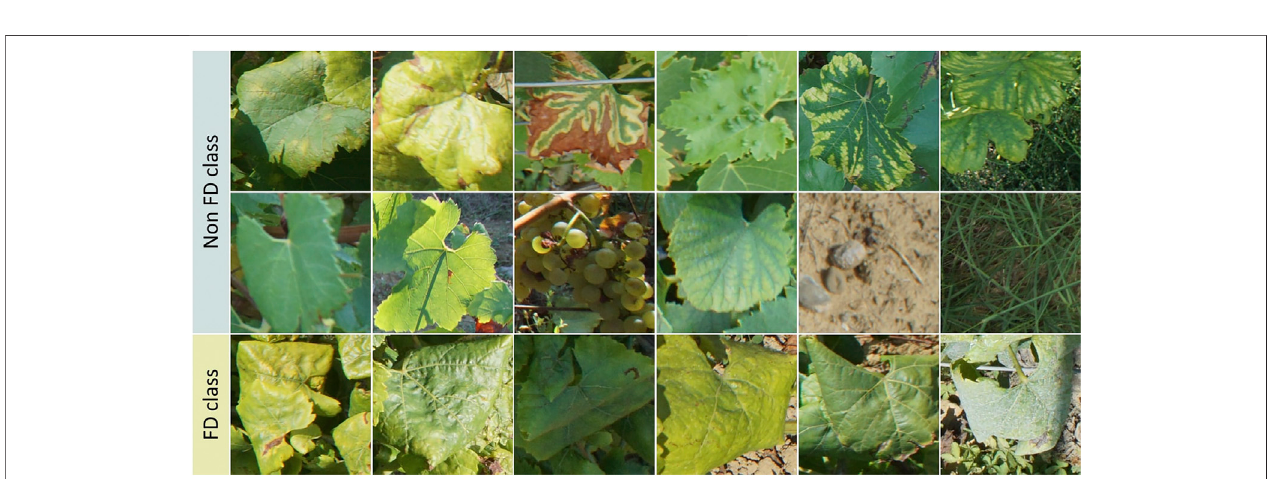
FIGURE 3 | Examples of samples from the CNN training dataset for FD and Non-FD